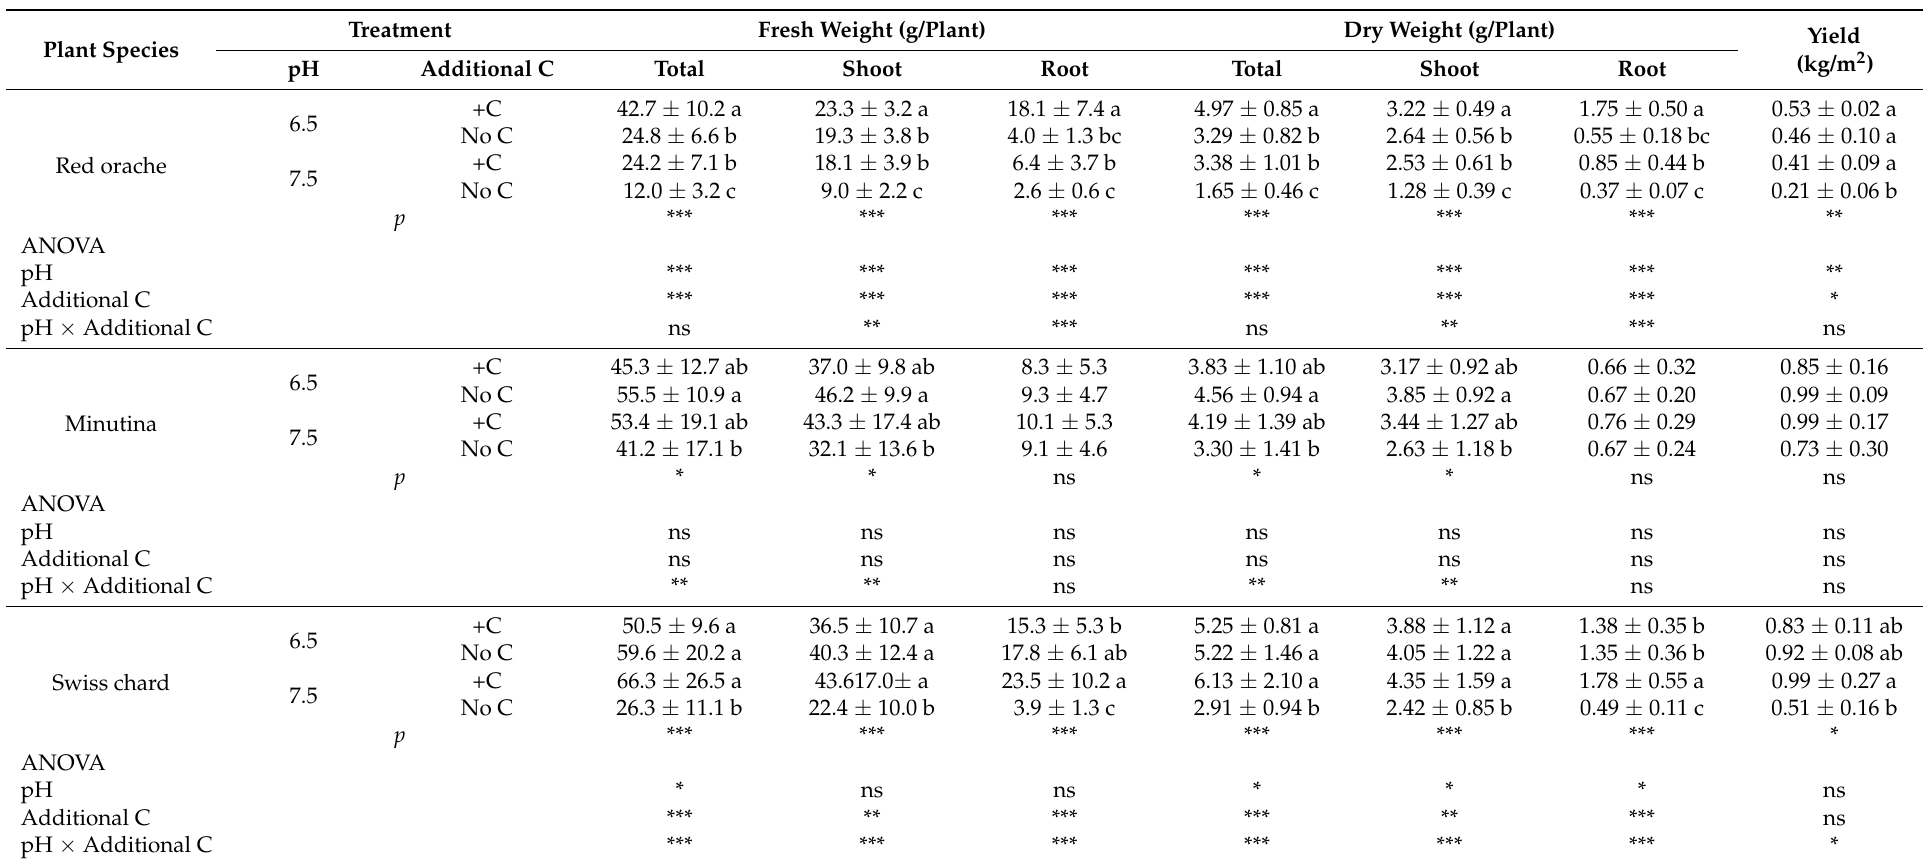
Table 2. Fresh and dry weight of red orache, minutina, and Swiss chard in aquaponics under two pH levels with or without additional C in the first harvest. Plant